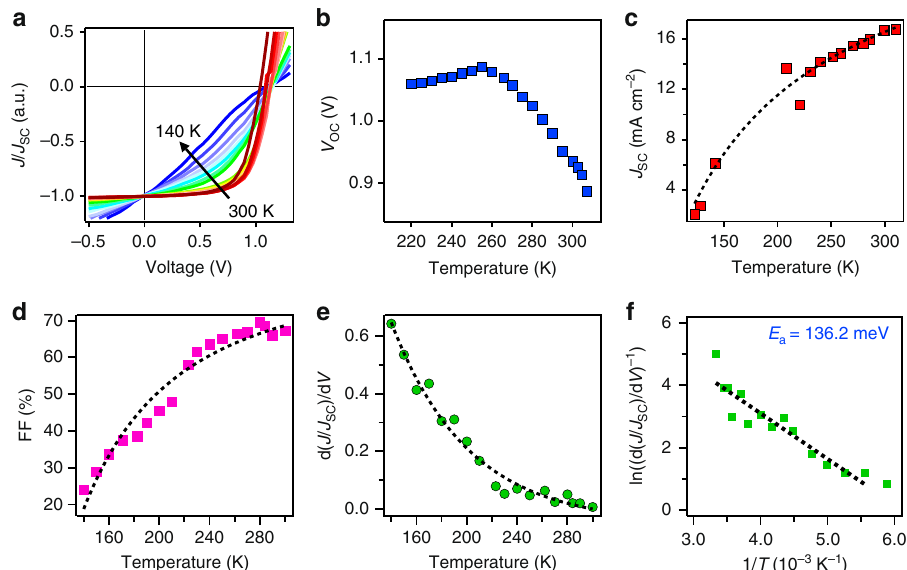
Fig. 4 Device characterization under low temperatures. a Normalized light J – V curves under 1-Sun illumination for a device with absorber thickness of 220 nm. b J SC , c V OC , and d fi ll factor (FF) as a function of temperature with the dashed line as guidance to the eye. e Extracted J – V slope at SC at various temperatures with the dashed line as fi tting curve and f the linear plot following Arrhenius equation by plotting the inverse J – V slope in natural log scale against 1/ T with dashed line as the linear fi